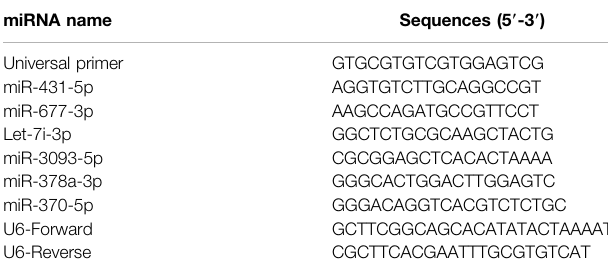
TABLE 2 | The miRNA-speci fi c primer